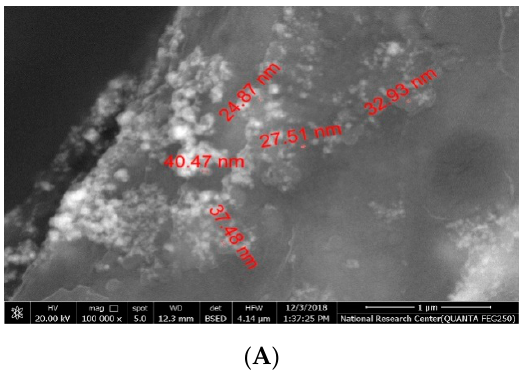
Figure 3. Total ion chromatogram of LC–MS of ethanolic extract of MS.